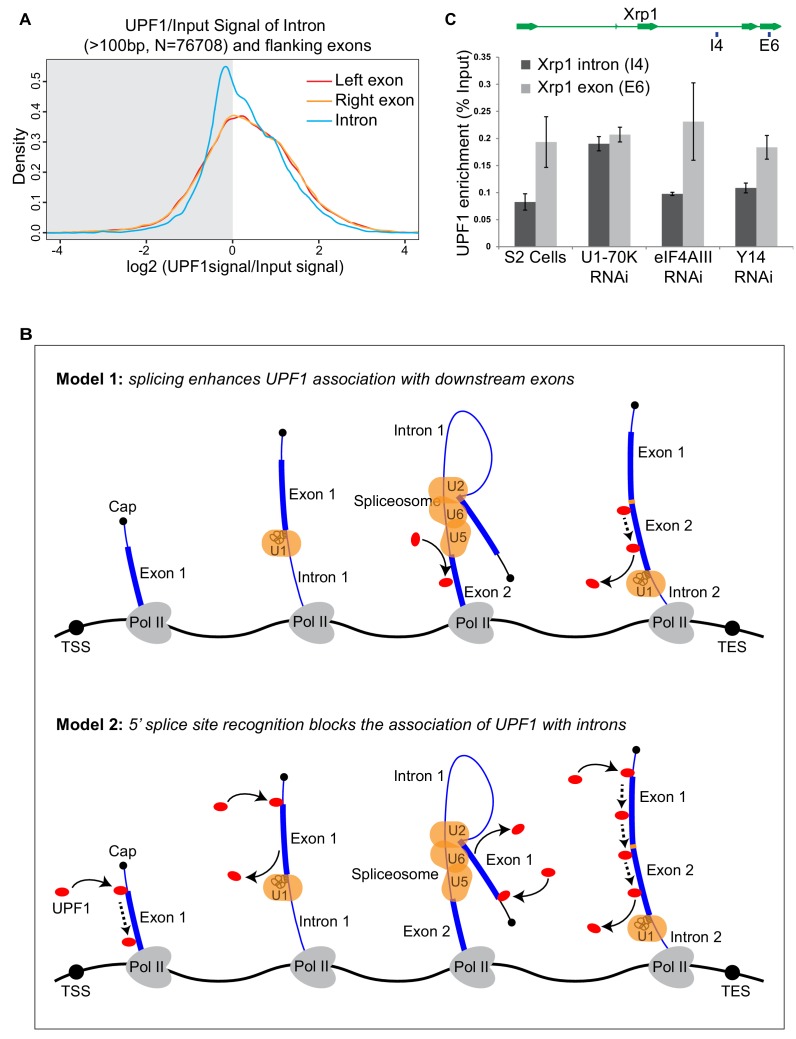
UPF1 association with nascent transcripts might depend on 5’ splice sites recognition.(A) Density plots of UPF1 enrichment at either the exon before (red line), exon after (orange line) or the intron (blue line). The x-axis shows the log2 of the normalised (by input) UPF1 ChIP signal; the right half of the graph shows the density of the values that are enriched, the left half (shadowed) those that are not. (B) Proposed models of how UPF1 scanning of the nascent transcript is connected to intron recognition during spliceosome assembly: Model 1 (top) predicts that splicing enhances binding of UPF1 to downstream exons, Model 2 (bottom) that intron recognition blocks UPF1 association with introns. Spliceosomal snRNPs (U1, U2/U6 and U5) are represented by orange oval shapes, the squiggle drawing within U1 snRNP signifies the base pairing between U1 snRNA and the 5’ ss; TSS indicate the transcription start site; and TES, the transcription end site. Exons are indicated by either thin blue lines (5’ UTRs) or rectangles (coding regions). (C) Real-time PCR quantification of UPF1 ChIP enrichment (two replicates) at intron (I4) or exon (E6) of the Xrp1 gene, in either normal S2 cells or cells RNAi depleted of the proteins indicated. Error bars indicate ±Standard Error.